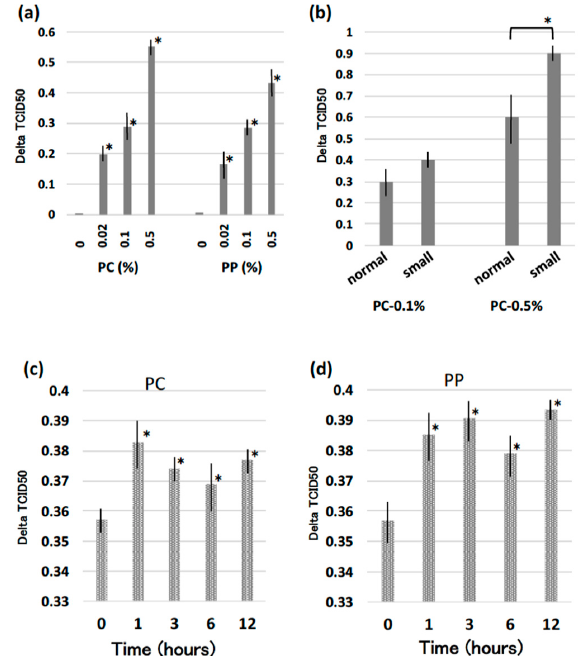
Figure 4. E ff ects of VB on molded products. ( a ) Dependence of VB concentration. ( b ) E ff ects of the Figure 4. Effects of VB on molded products. ( a ) Dependence of VB concentration. ( b ) Effects of the particle size of VB crystal. ( c ) Time required for the onset of VB e ff ects in polycarbonate (PC). ( d ) Time particle size of VB crystal. ( c ) Time required for the onset of VB effects in polycarbonate (PC). ( d ) Time required for the onset of VB e ff ects in polypropylene (PP). * p < 0.001 relative to VB, 0 µ g / mL or required for the onset of VB effects in polypropylene (PP). * p < 0.001 relative to VB, 0 μ g/mL or normal normal ( b ). ( b ).